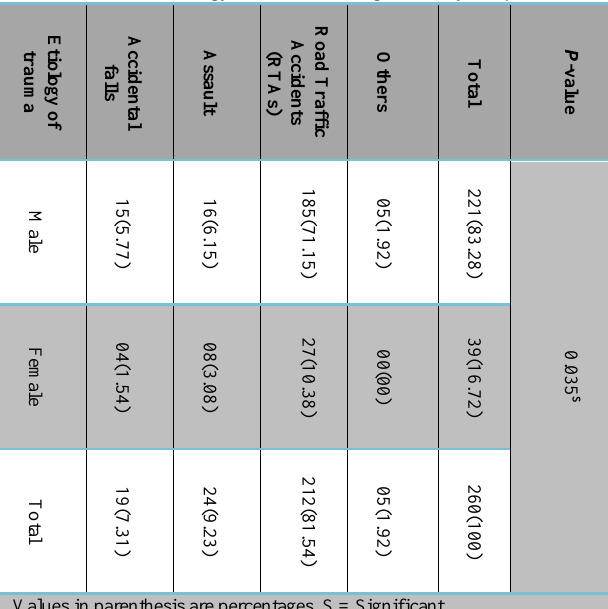
Table 2. Etiology of trauma among the study